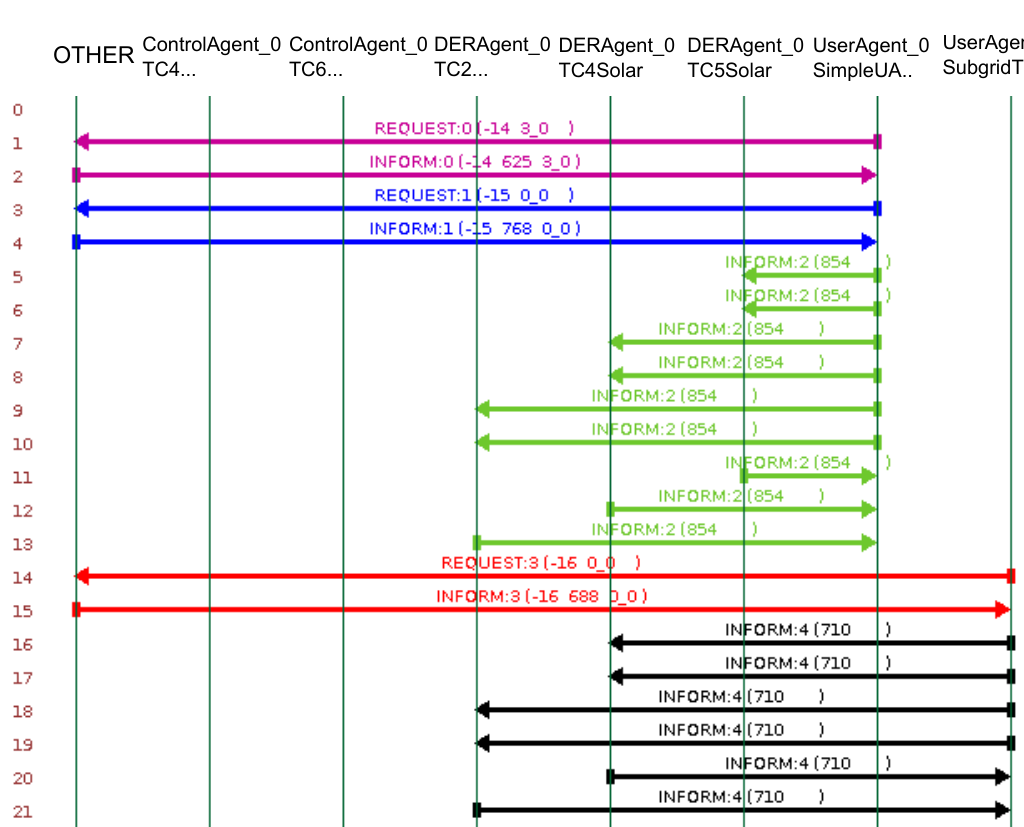
Figure 10. Interaction among User Agents and DER Agents limited by the group membership as described in Figure